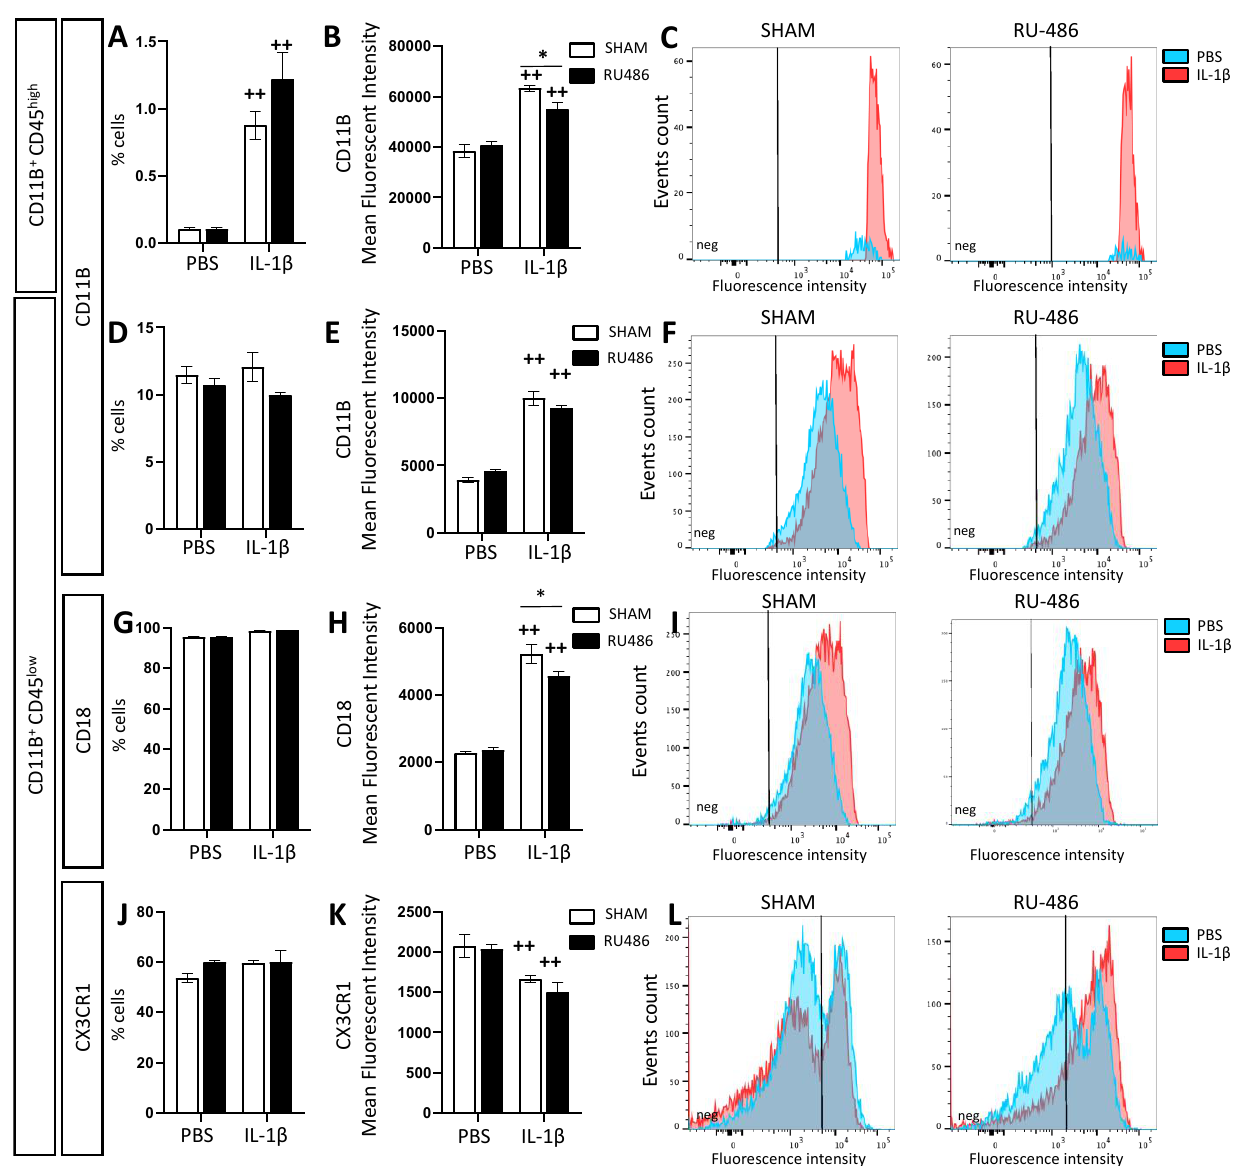
Figure 2. Flow cytometry analysis of the impact of RU-486 on microglial reactivity at P3. Flow cytometry analysis of microglial reactivity at P3 in mice with spontaneous birth or RU-486-induced labor followed by the perinatal administration of PBS or IL-1β. Results are presented in two popu- lations: CD11b + /CD45 high ( A – C ) and CD11b + /CD45 low ( D – L ). The percentages of each population are presented in ( A , D ), respectively. In each population, mean fluorescent intensities (MFI) were eval- uated for CD11B ( B , E ), CD18 ( H ), and CX3CR1 ( K ). For each marker, a representative image of MFI was selected ( C , F , I , L ). Two-way analysis of variance (ANOVA) corrected by the Sidak test ( n = 6/group, mean SEM), (* p ≤ 0.05 comparing RU-486-induced delivery vs. spontaneous delivery, ++ p ≤ 0.01 comparing IL-1β vs. PBS).